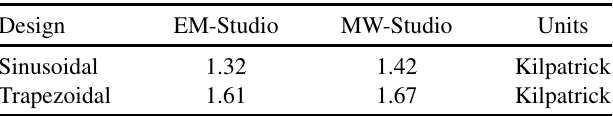
TABLE XVI. Peak surface electric field values calculated with both EM-Studio and MW-Studio for both the sinusoidal and trapezoidal designs.